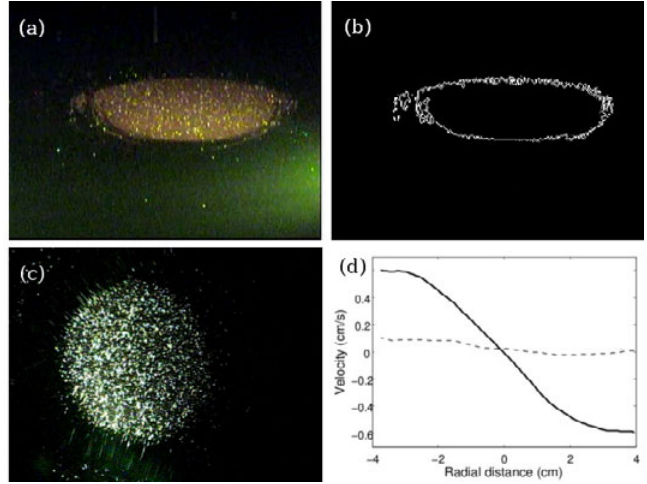
Figure 2. Experimentally generated anticyclonic vortex with ¯ N = 2 . 3 rad / s, f = 2 rad / s: (a) side view; (b) extracted contour by image processing to determine the aspect ratio α = 0 . 3 (thickness 3 . 8 cm and diameter 12 . 6 cm); (c) top view; (d) velocity profile in an horizontal plane obtained by PIV post-processing (we measure a velocity field from sequences of top views like (c), from which velocity profiles are extracted along the diameter of the